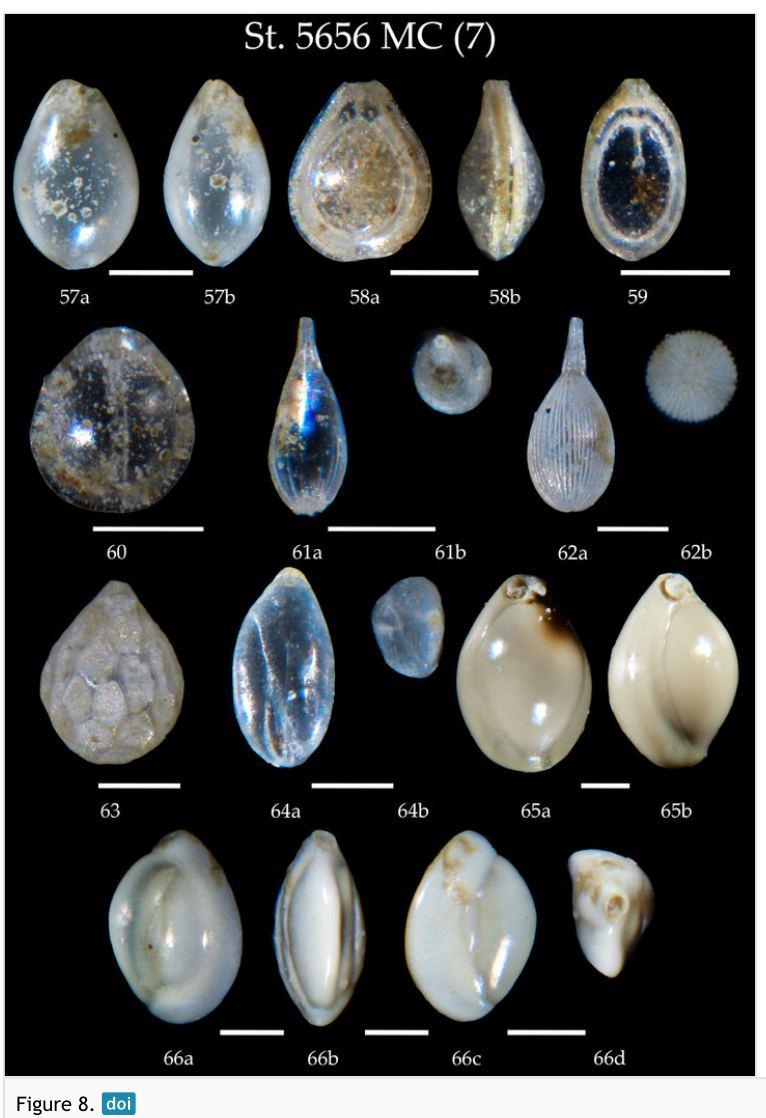
Figure 8. Station 5656 MC (continued). 57 – 60 Fissurina sp.; 61,62 Lagena sp., a side view, b apertural view; 63 Oolina sp.; 64 Globobulimina pacifica , a side view, b apertural view; 65 Pyrgo williamsoni , a apertural view, b side view; 66 Quinqueloculina seminulum , a-c side view, d apertural view. Scale 100